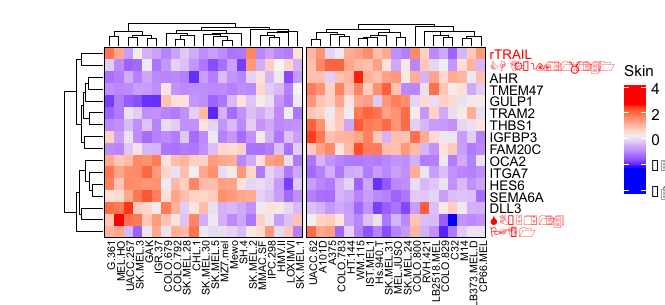
Figure 4. AhR signatures to identify therapeutic strategies in various cancer cell lines. ( A ) Volcano plot showing the correlation of drug efficiency (IC50) in various cancer cell lines (lung, brain-CNS, breast, skin) from the GDSC database (Genomics of Drug Sensitivity in Cancer, https://discover.nci.nih.gov/cellminercdb) with normalized level of AhR mRNA (RNAseq data). Drugs that are the most efficient when the AhR level is low are shown on the left, whereas drugs that are the most efficient when the AhR level is high are shown on the right. ( B ) Volcano plot showing the correlation of drug efficiency (IC50) in various cancer cell lines (lung, brain-CNS, breast, skin) from the GDSC database (Genomics of Drug Sensitivity in Cancer, https://discover.nci.nih.gov/cellminercdb) with the level of AhR regulator ( AhRR) mRNA. ( C , D ) Expression Heatmap showing expression of the genes that correlate the most (positively or negatively) with that of AhR in lung-cancer cell lines ( C ) and skin melanoma cell lines ( D ) in terms of selected therapies for which the efficiency correlates with the level of AhR expression. Genes and clusters with similar expression profiles across the cohort are placed close to each other in the